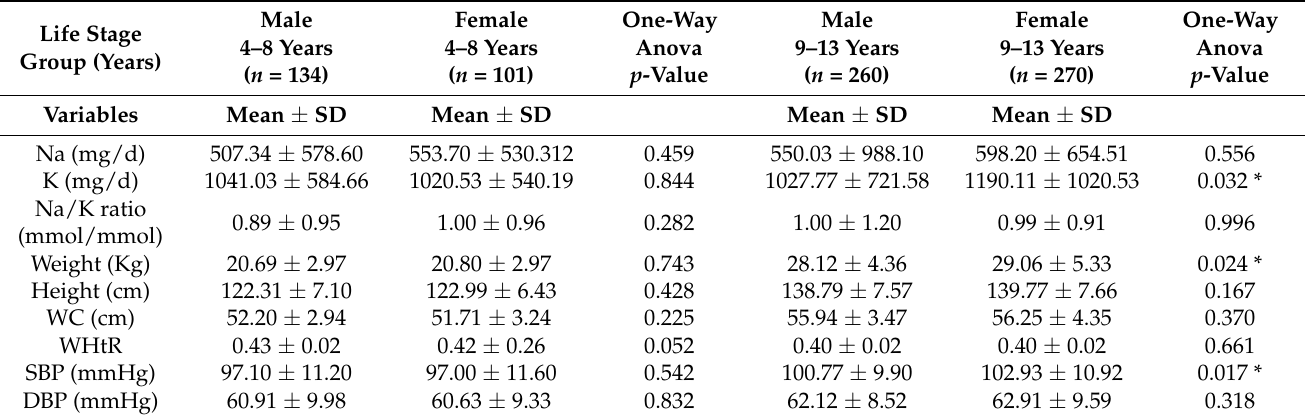
Table 2. Descriptive characteristics of the population according to sex and age.